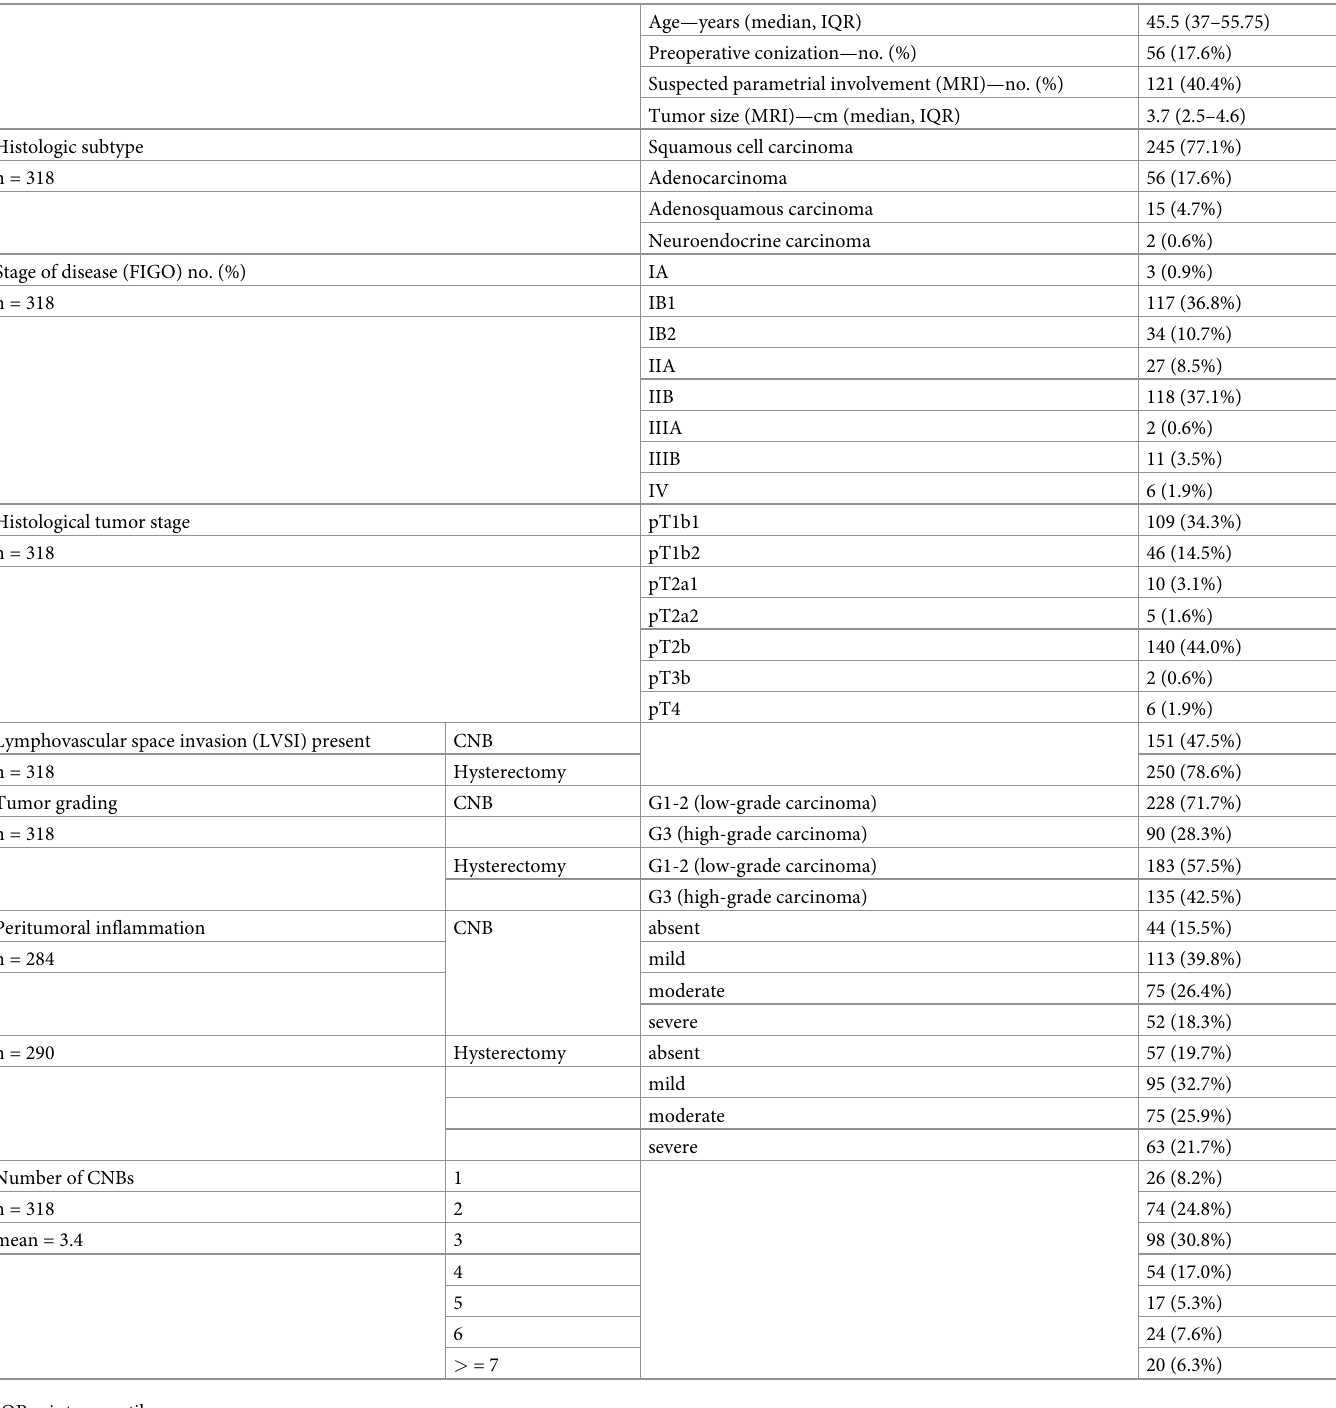
Table 1. Patient- and tumor